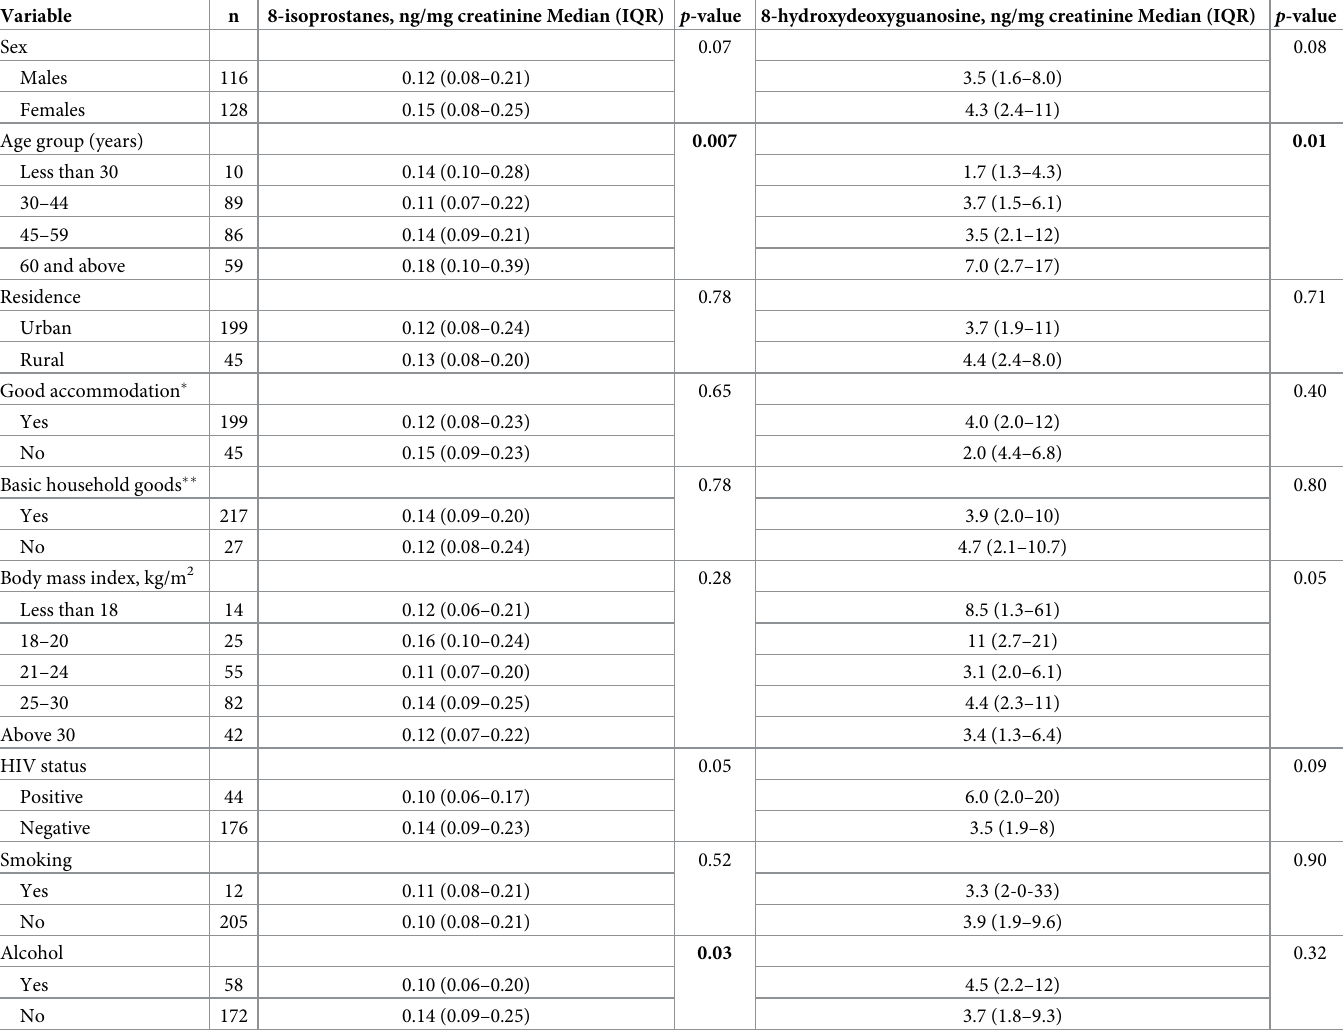
Table 1. Characteristics of enrolled participants in relation to markers of oxidative